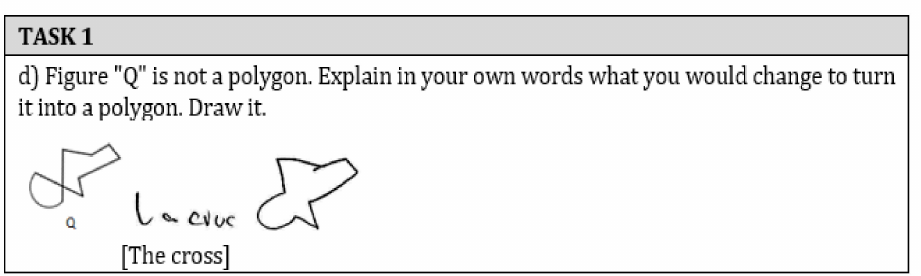
Figure 9. The answer given by G1S1 when performing the task of transforming a non-polygon into a